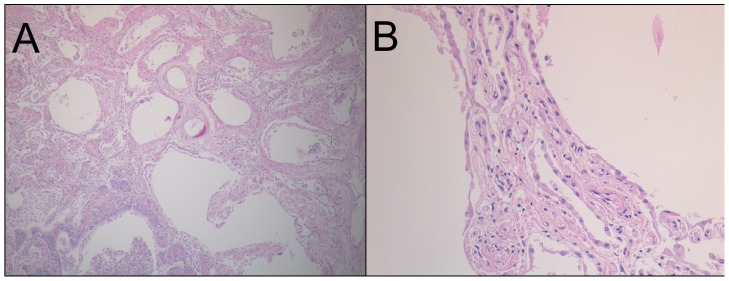
Histological demonstration of the NSIP pattern of IPF in the patient's lungs. Microscopic examination of the lungs.(A) 40×; (B) 400×. Note uniform fibrotic thickening of the alveolar septae and type II pneumocyte hypertrophy. There was no histologic evidence of sarcoidosis, hypersensitivity pneumonitis, organizing pneumonia, or diffuse alveolar damage.